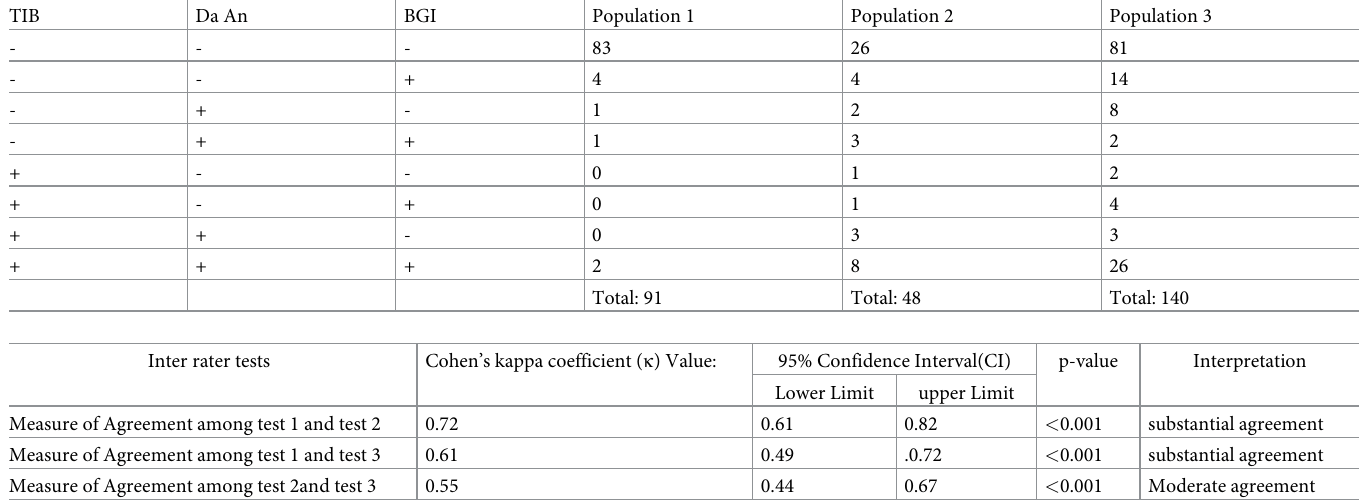
Table 5. a. Possible frequencies combination of dichotomized test results of the three assays among three populations in Addis Ababa, Ethiopia, 2021. b. Measure of Cohen’s kappa coefficient ( κ ) Value among the three tests kits, Addis Ababa, Ethiopia, 2021. TIB Da